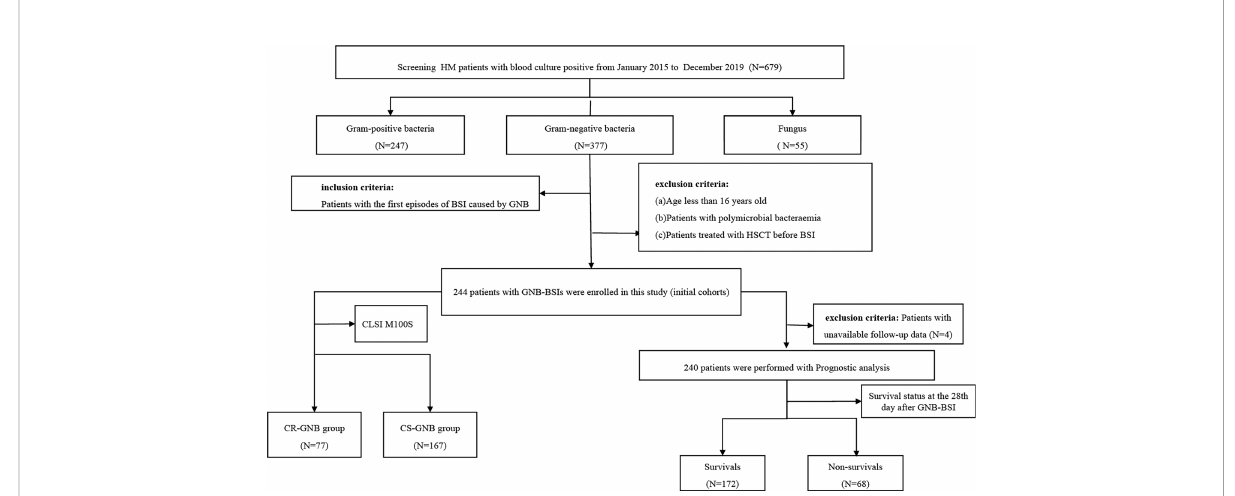
FIGURE 1 Flowchart of the study design. HM, hematological; CLSI,clinical and laboratory standards institute; GNB, gram-negative bacteria; BSI, bloodstream infection; CR, carbapenem-resistant; CS,